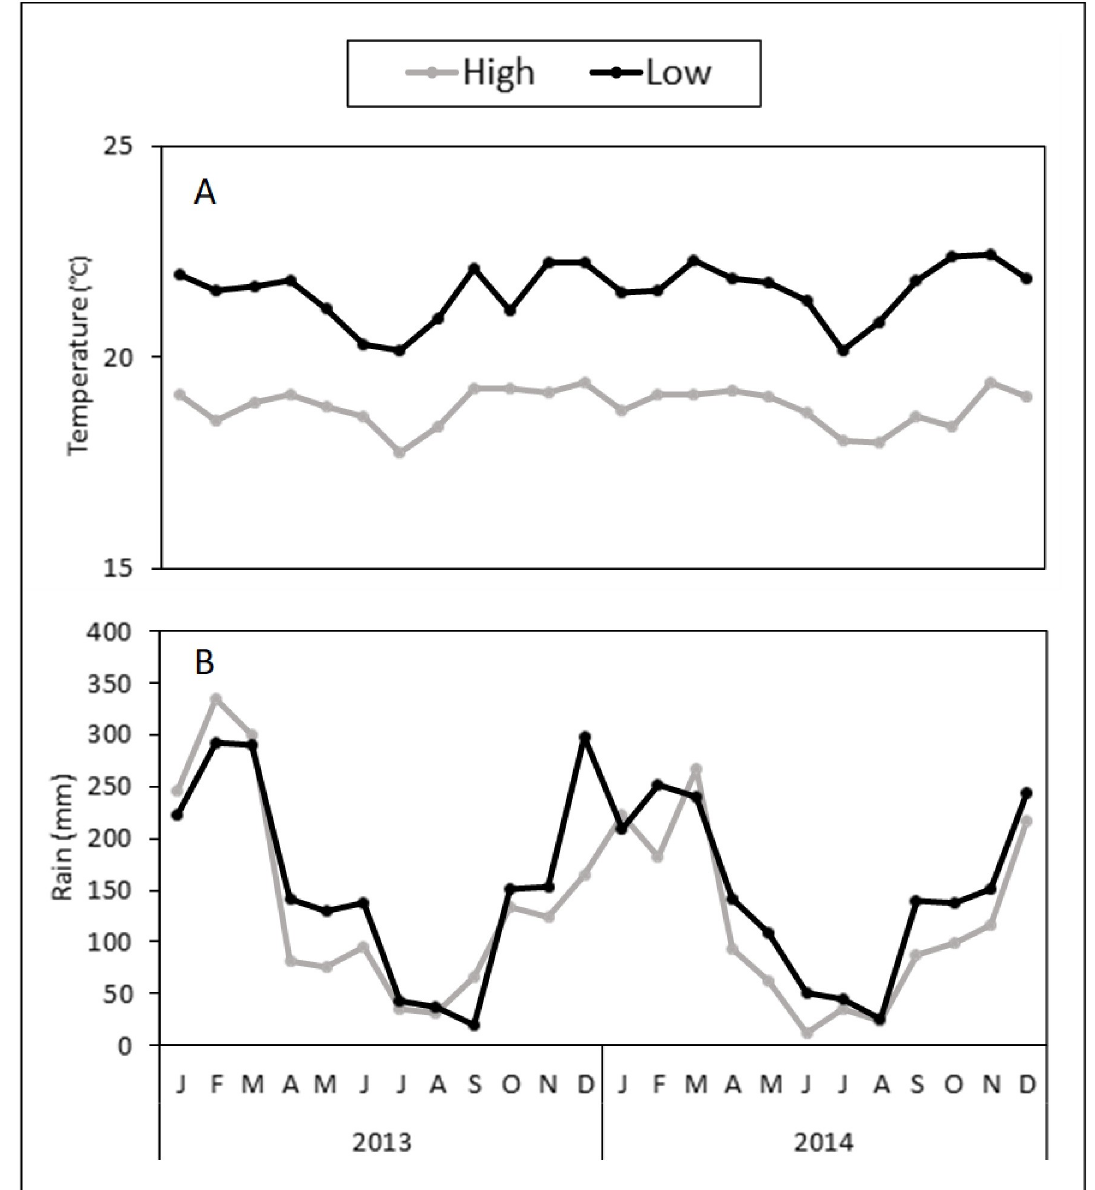
Fig 9. Weather conditions at study sites. Monthly temperature (A) and rainfall (B) at different elevations (low and high) and seasons (dry and rainy) in Oxapampa, Peru, from 2013–2014. The dry “winter” season corresponds from May to October, while the rainy “summer” season corresponds from November to